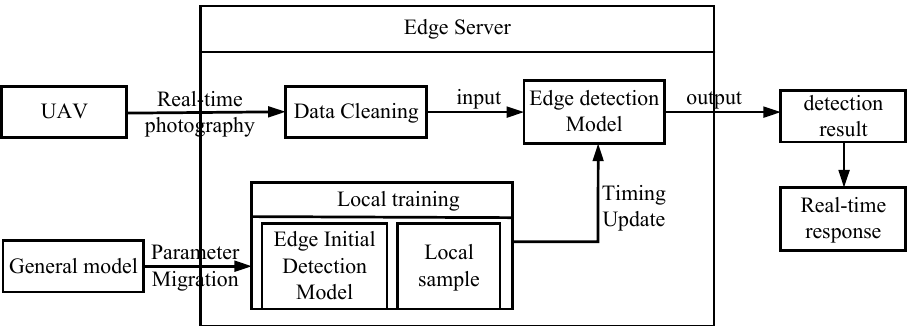
Figure 5. Flow of edge-side algorithm detection and update.